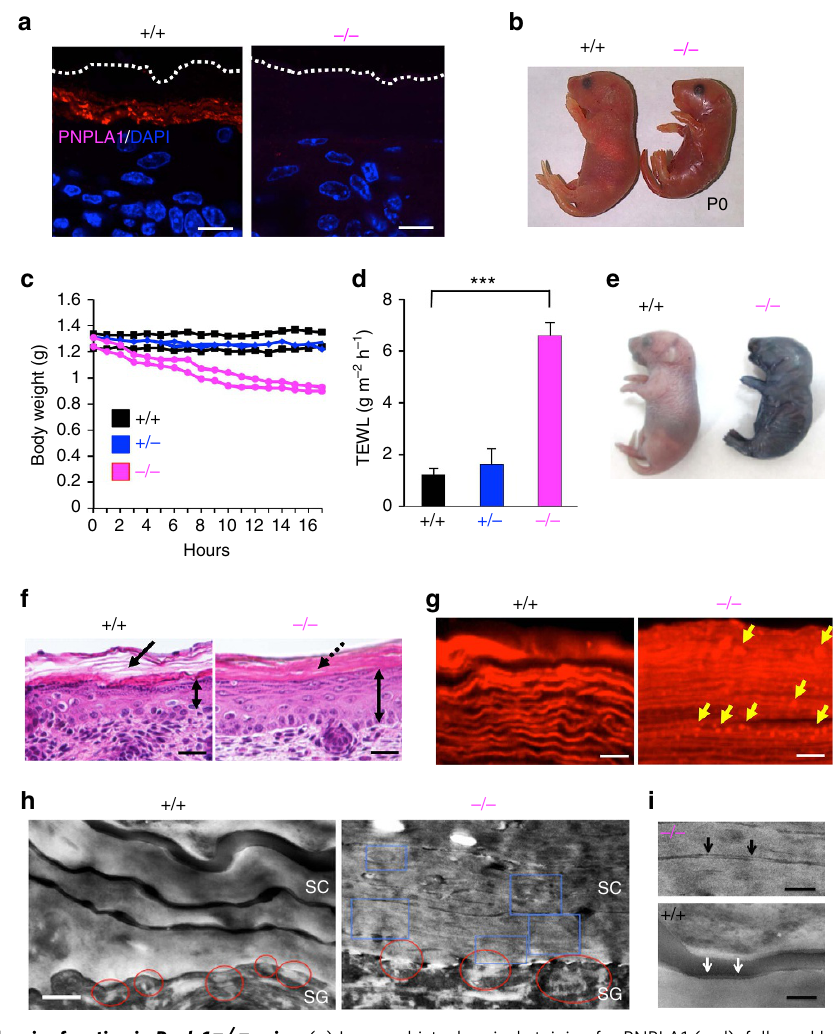
Figure 1 | Impaired skin barrier function in Pnpla1 (cid:2) / (cid:2) mice. ( a ) Immunohistochemical staining for PNPLA1 (red), followed by counterstaining with DAPI (blue), in skin sections from Pnpla1 þ / þ and Pnpla1 (cid:2) / (cid:2) newborns. Dashed lines indicate the upper border of the epidermis. ( b ) Gross appearance of Pnpla1 þ / þ and Pnpla1 (cid:2) / (cid:2) newborns at P0. ( c ) Monitoring of body weights of Pnpla1 þ / þ , Pnpla1 þ / (cid:2) and Pnpla1 (cid:2) / (cid:2) mice (two pups for each) after Caesarean section at E18.5. ( d ) Skin permeability as assessed by TEWL on the dorsal skin surface of Pnpla1 þ / þ ( n ¼ 19), Pnpla1 þ / (cid:2) ( n ¼ 21) and Pnpla1 (cid:2) / (cid:2) mice ( n ¼ 21) (mean ± s.e.m., *** P o 0.001 in an unpaired, two-tailed Student’s t -test). ( e ) Toluidine blue exclusion assay using neonatal Pnpla1 þ / þ and Pnpla1 (cid:2) / (cid:2) mice. ( f ) Histology of dorsal skin sections from newborn Pnpla1 þ / þ and Pnpla1 (cid:2) / (cid:2) mice stained with hematoxylin and eosin. Arrow indicates a basket weave structure in the SC of WT mice. Mutant epidermis was notably thicker (double-headed arrows) and had a more tightly packed SC (dashed arrow) than WTepidermis. ( g ) Staining of SC lipids with Nile red. Continuous linear lipid structures in the SC of Pnpla1 þ / þ mice were replaced by a dot-like pattern (yellow arrows) in the SC of Pnpla1 (cid:2) / (cid:2) mice. ( h , i ) Transmission electron microscopy of skins of Pnpla1 þ / þ and Pnpla1 (cid:2) / (cid:2) newborn mice. Compared with Pnpla1 þ / þ skin, Pnpla1 (cid:2) / (cid:2) skin displayed numerous lipid aggregates in corneocytes (blue boxes), abnormalites in the secreted contents at the SG–SC interface (red circles) ( h ), and impaired formation of the CLE (arrows) ( i ). Scale bars; 20 m m ( a , f ), 5 m m ( g ), 0.4 m m ( h ) and 0.2 m m ( i ). Representative ( a – c , e – i ) or complied ( d ) results from at least three experiments are